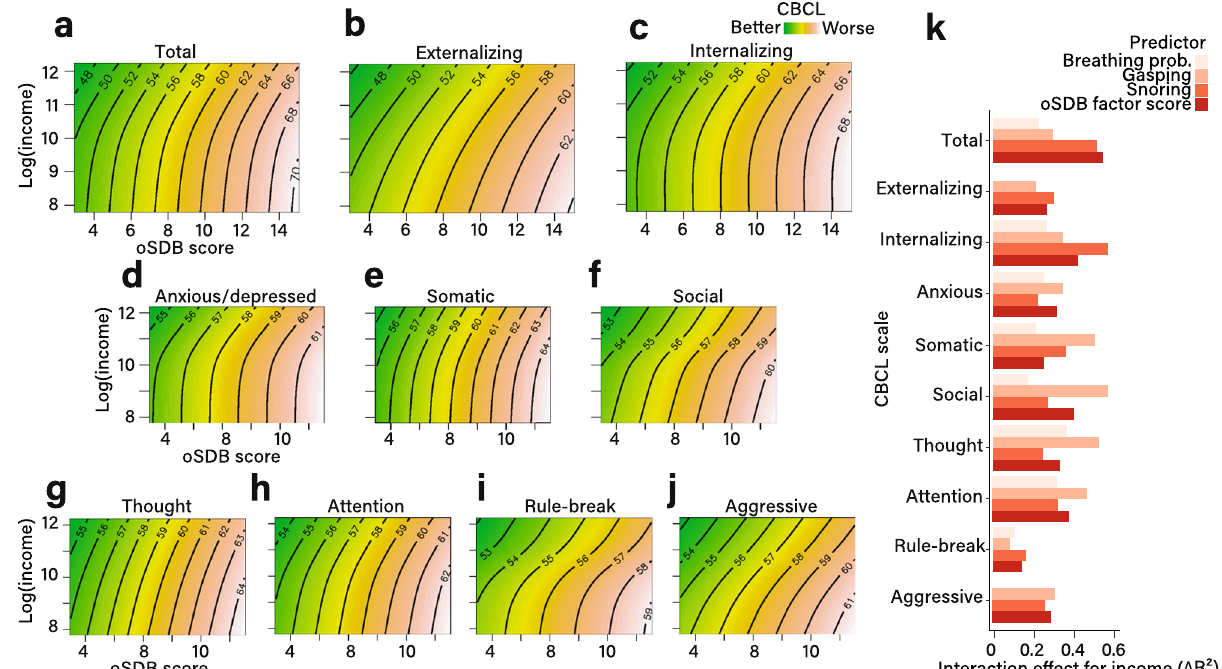
Fig. 2 Interaction between household income and obstructive sleep disordered breathing in predicting problem behaviors. a – j Each contour plot, derived from 10,140 children in the Adolescent Brain Cognitive Development study, shows the interaction between household income and obstructive sleep disordered breathing (oSDB) factor score in predicting the CBCL scores. The three composite CBCL scales are shown in a – c while the individual syndrome CBCL scales are shown in d – j . The median of each income class was log-transformed due to positive skew. The parent-reported obstructive sleep disordered breathing (oSDB) factor score is shown on the x -axis and the natural log of income on the y -axis. The angled orientation of the contours indicates an interaction between income and oSDB on each CBCL score. All models included the summed effects of age, sex, race/ethnicity, asthma as well as the recruitment site as a random effect. k The effect size estimates were calculated by measuring the change in the overall proportion of variance (expressed as a percentage) by adding the interaction term to the no-interaction model linking oSDB factor score to each CBCL measure. Source data are provided as a source data fi